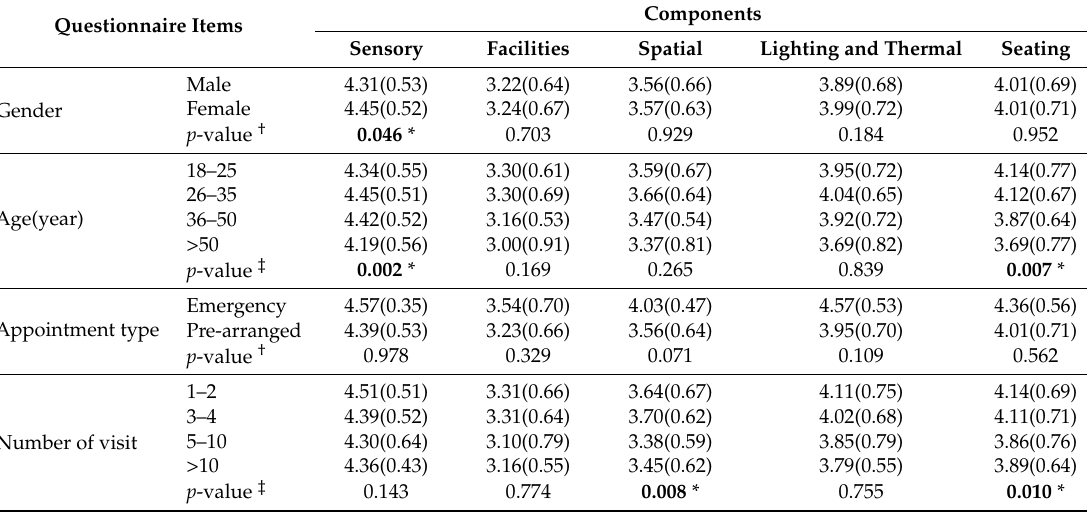
Table 4. Comparison of mean principal component analysis (PCA) scores between demographic